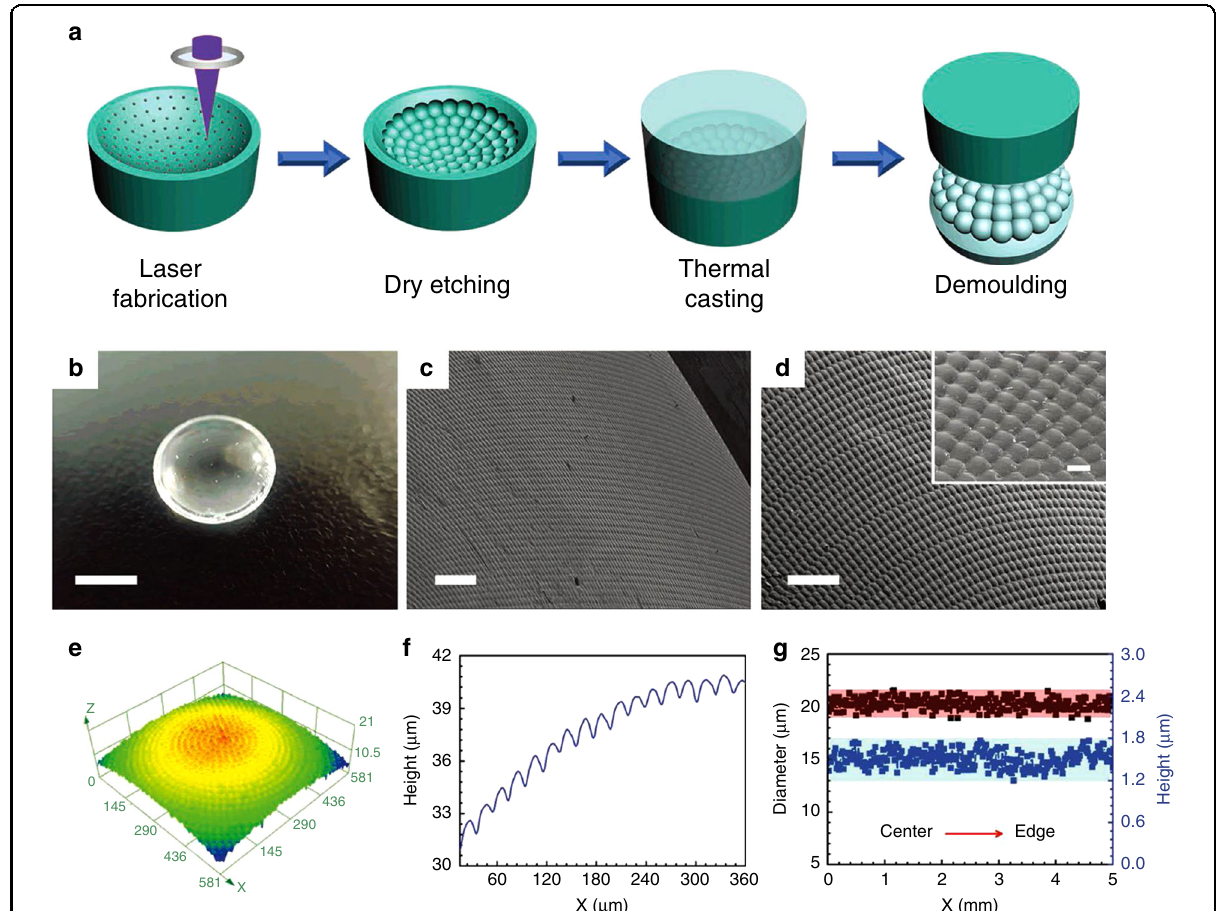
Fig. 11 Large area (cm 2 size) concave compound eyes structures fabricated on a curved K9 glass substrate using laser direct writing followed by dry etching 133 . a The schematic diagram of fabrication of sapphire concave compound eyes template and K9 glass compound eye. b Photo image (Scale bar: 5 mm), c SEM image (Scale bar: 100 μ m), and d ampli fi ed SEM image of K9 glass compound eyes (Scale bar: 100 μ m).